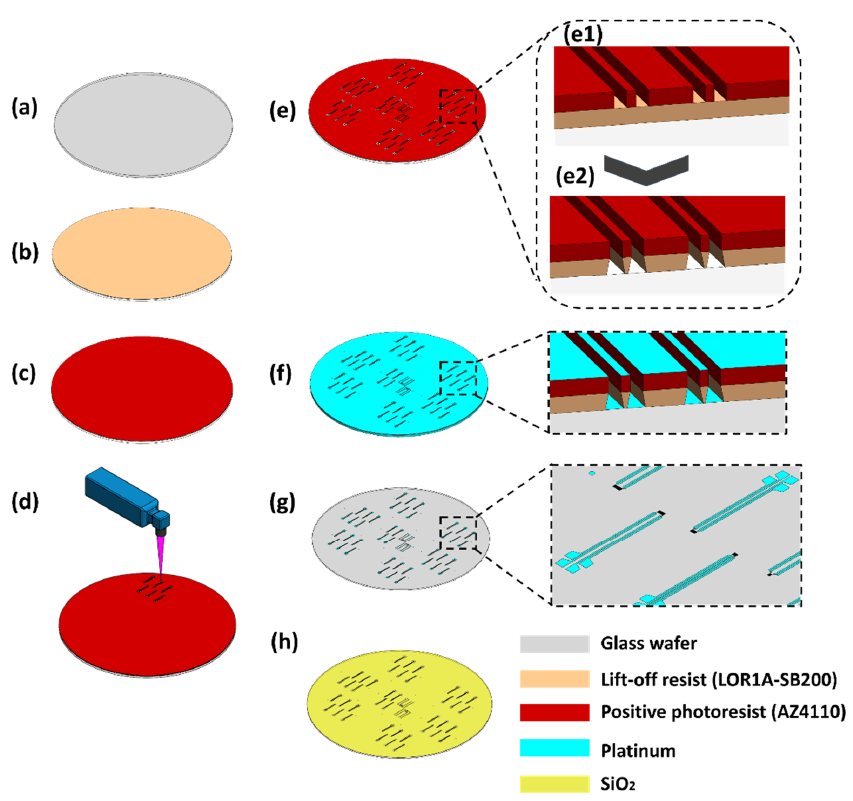
Figure 5. Schematic diagram of temperature microsensors patterning process: ( a ) glass wafer; ( b ) LOR1A-SB200 lift-off resist; ( c ) AZ4110 positive photoresist; ( d ) UV exposure; ( e1 ) developed resist and ( e2 ) LOR; ( f ) platinum deposition; ( g ) removal of the lift-off resist; and ( h ) deposition of SiO 2 .